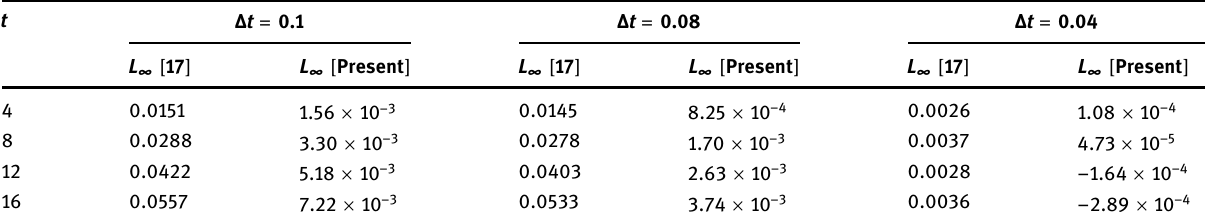
Table 2: Comparison of L ∞ errors fi rst - wave amplitude, = N 201 , = e